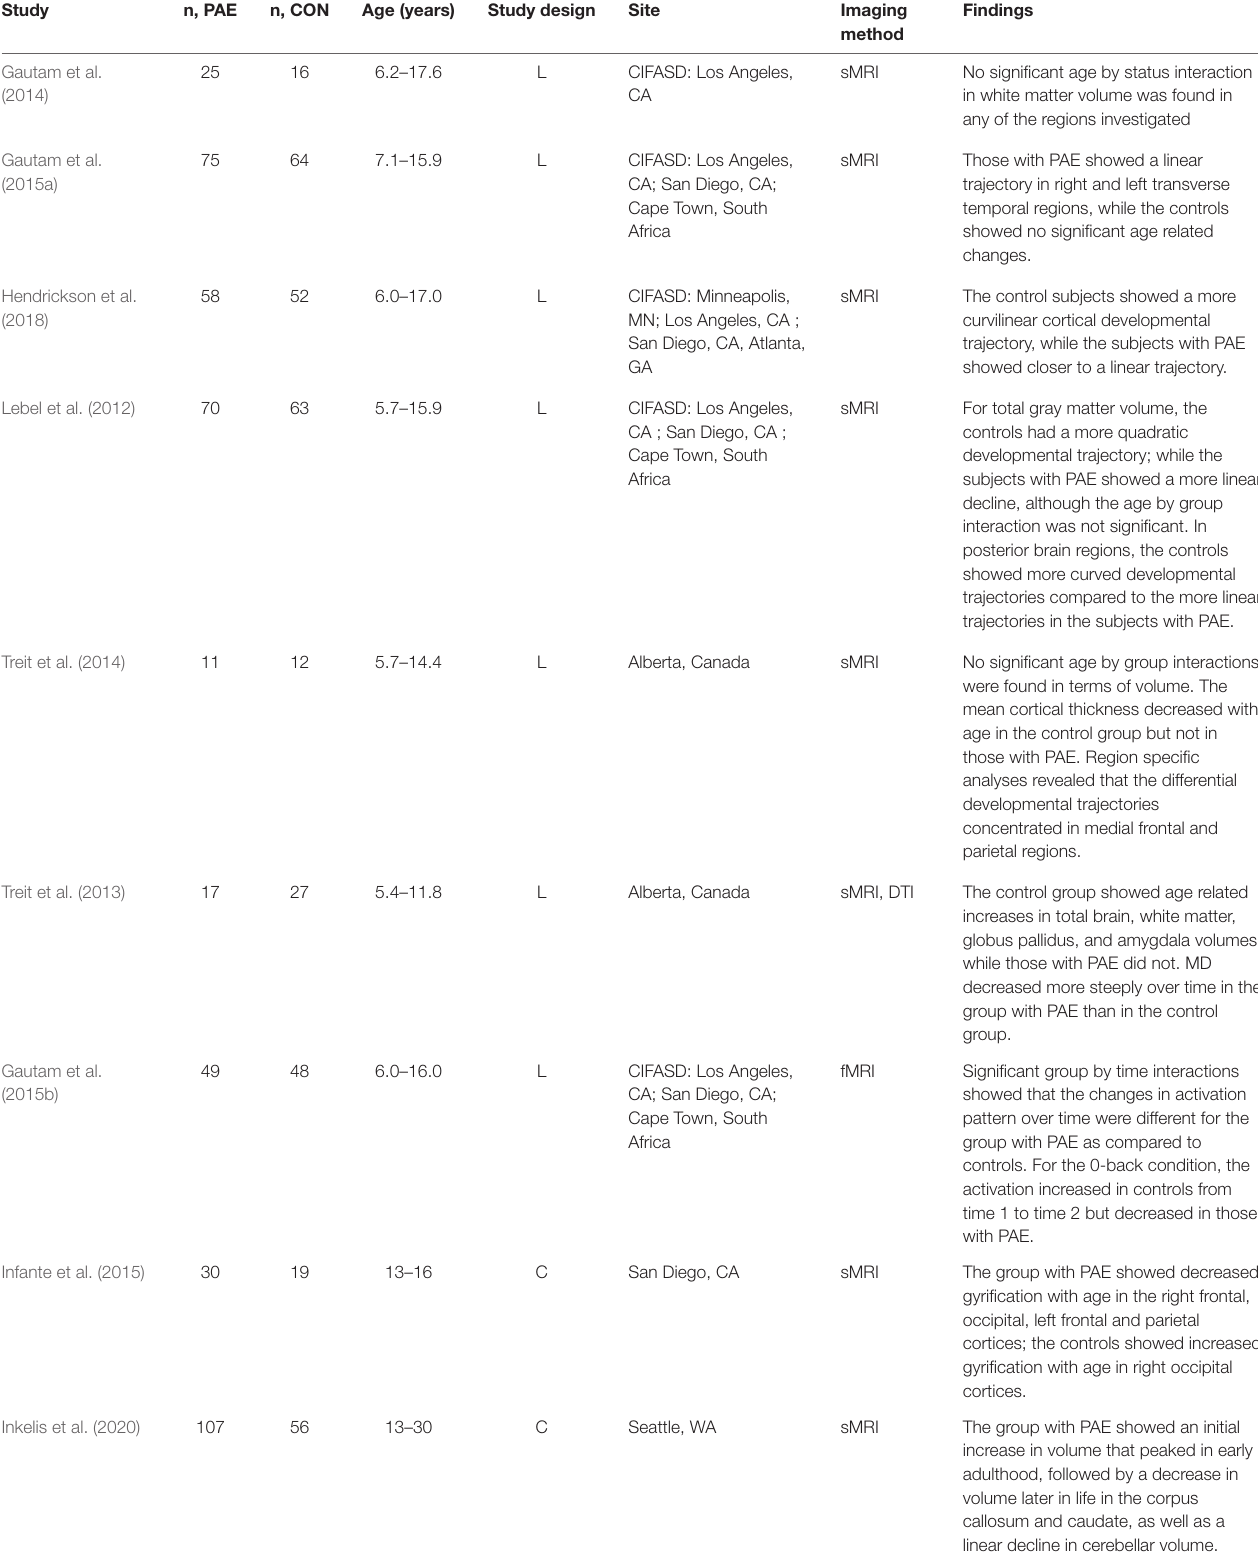
TABLE 1 | Summary of studies examining relations between prenatal alcohol exposure and age on